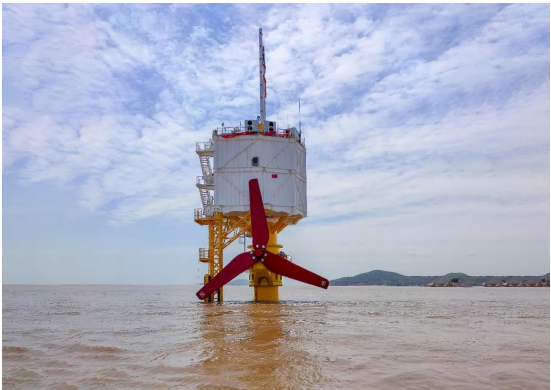
Figure 33. Offshore Step-up Station and 300 kW Turbine of CTG. Reproduced from [85].